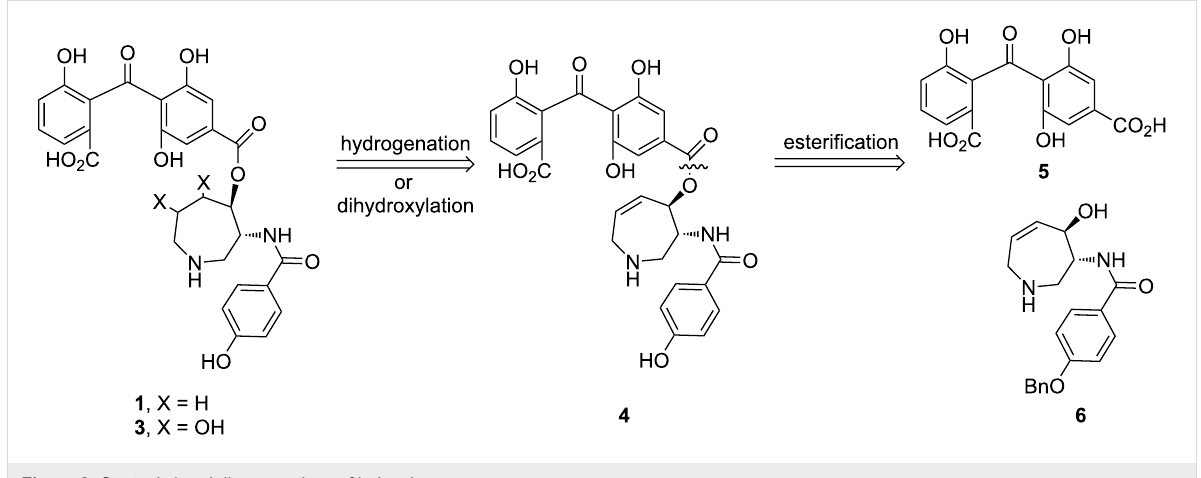
Figure 2: Strategic bond disconnections of